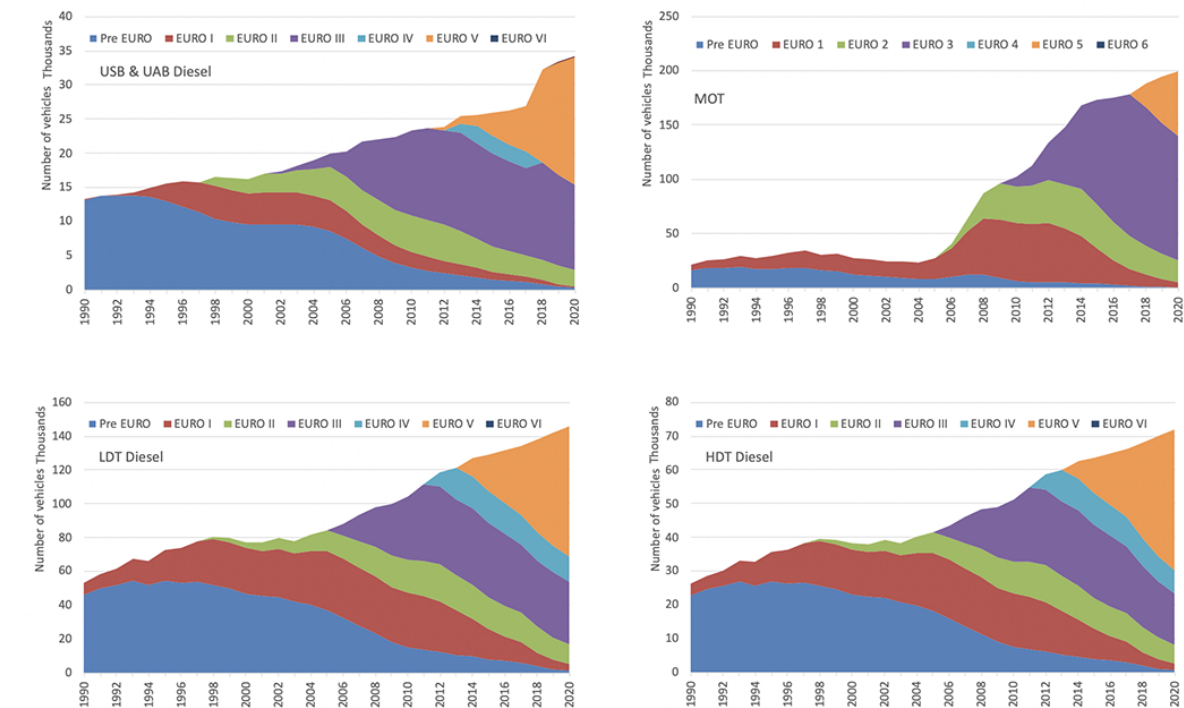
Figure 4. Emission standards and vehicle fleet in Chile, 1990–2020, for urban standard buses (USB), urban articulated buses (UAB), two- wheelers (MOT), light-duty trucks (LDT) and heavy-duty trucks (HDT). Table 6. Total annual exhaust emissions produced by on-road transportation in Chile, 1990–2020.